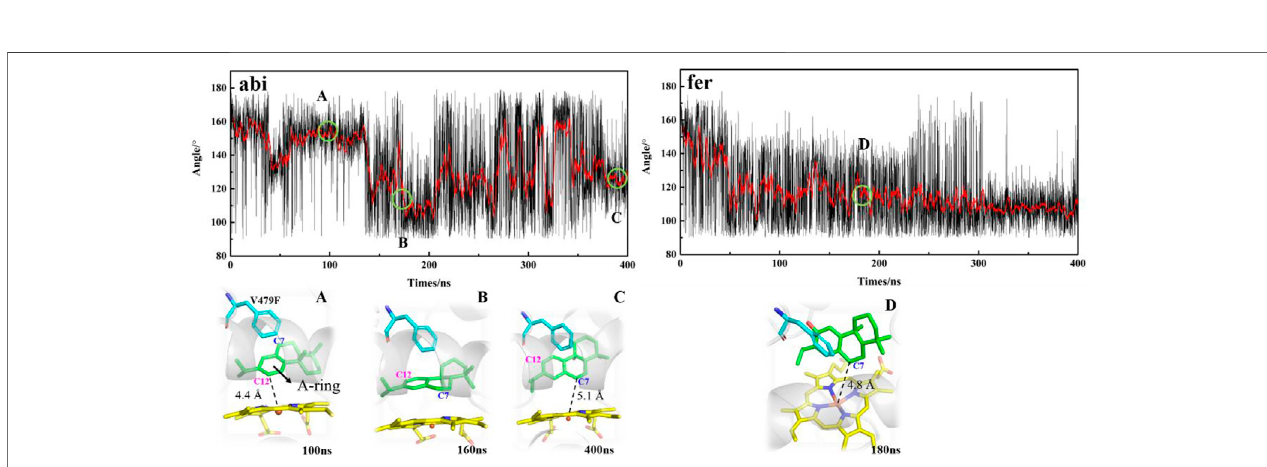
FIGURE 5 | Dihedral angle between A-ring of the ligand and aromatic side chain of F479 along the MD trajectories in mut-abi-Rest and mut-fer-Rest systems. The corresponding representative binding poses are also given. The distance evolutions are supplemented in Supplementary Figures S5, S6 .